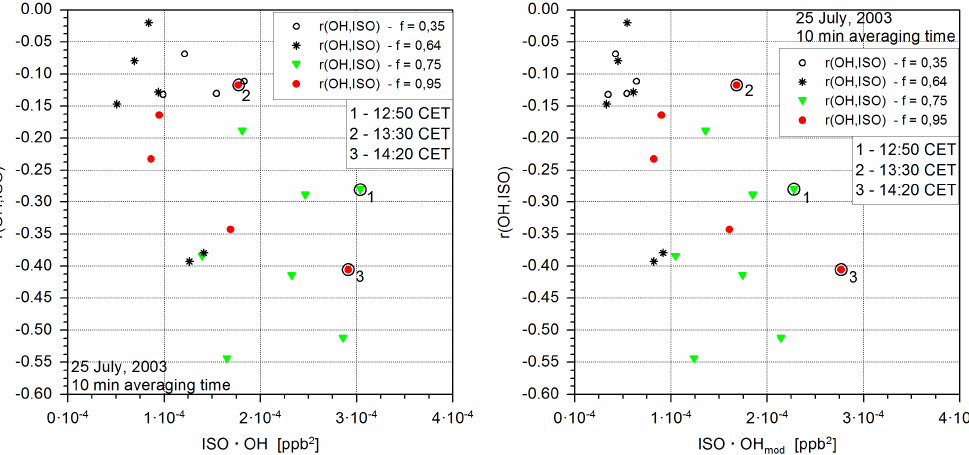
Figure 7. The correlation coefficient between isoprene and OH respectively OH mod as a function of the product of mean mixing ratios with the three points as discussed in Sects. 4.2.4 and